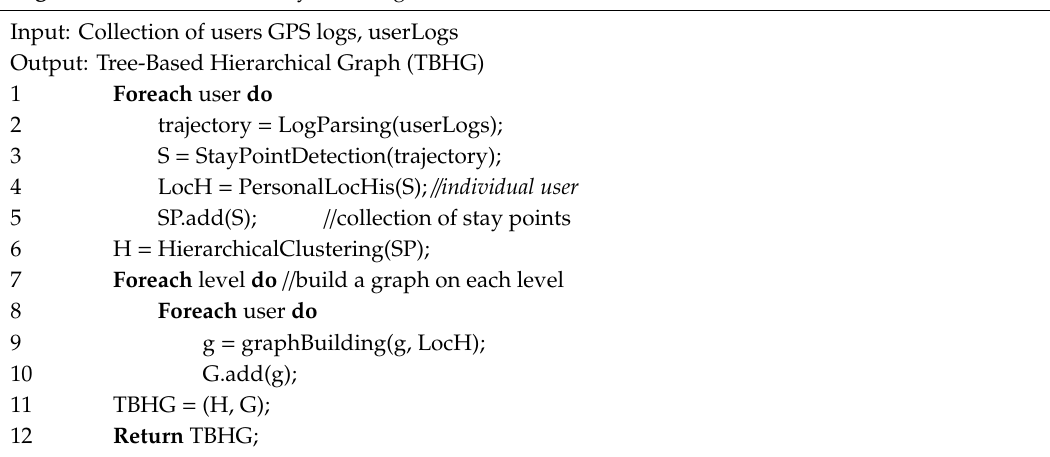
Algorithm 2. LocationHistoryModeling